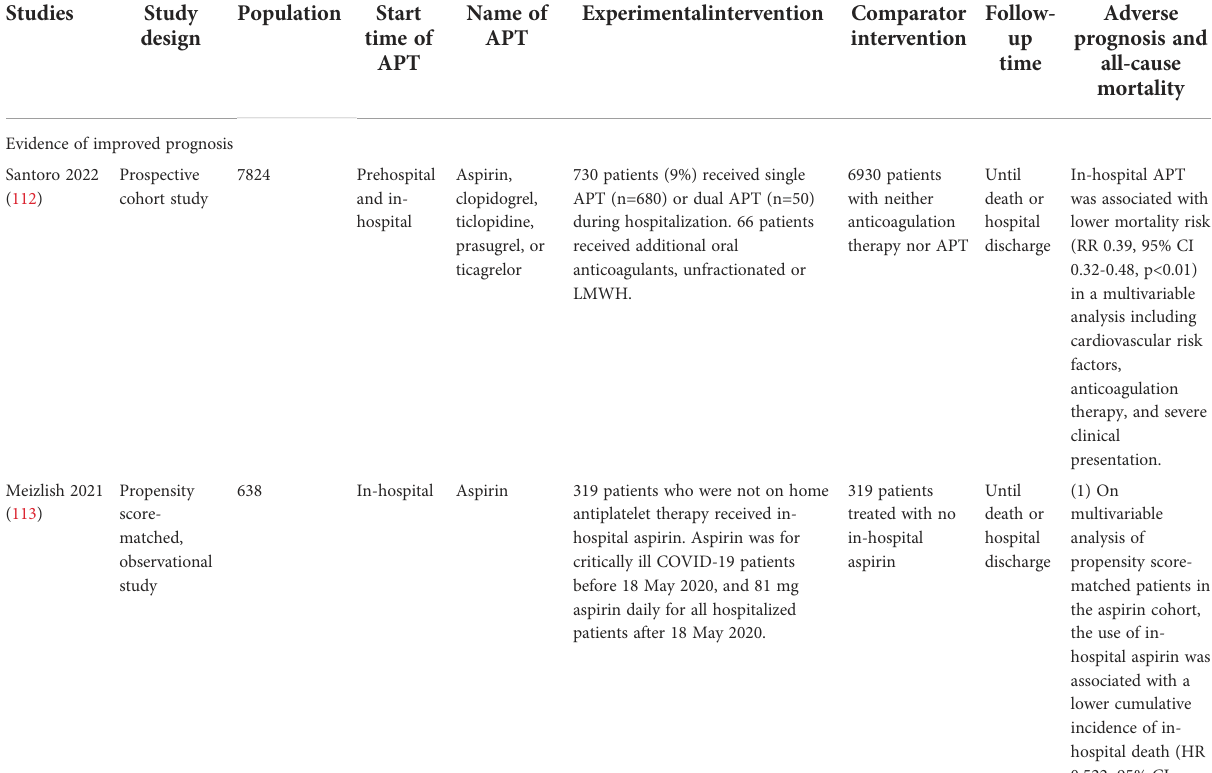
TABLE 1 Summary of studies on antiplatelet therapy in